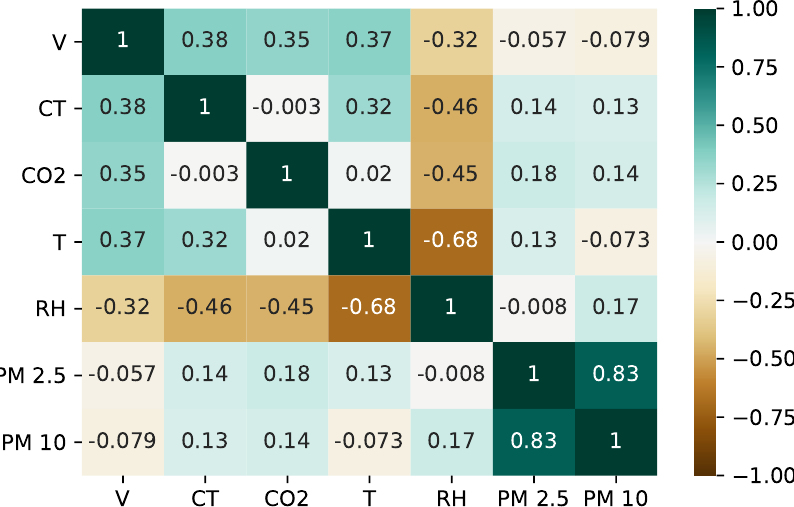
Figure 5. Correlation analysis using Spearman’s Rho